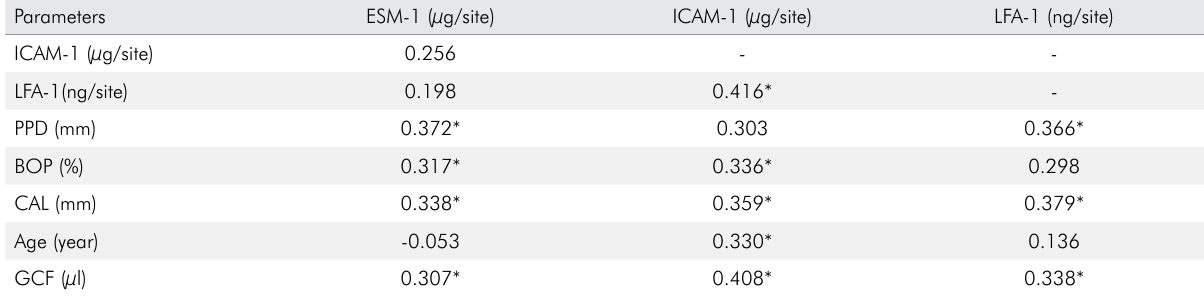
Pearson’s correlation, r. *Significant at the 0.05